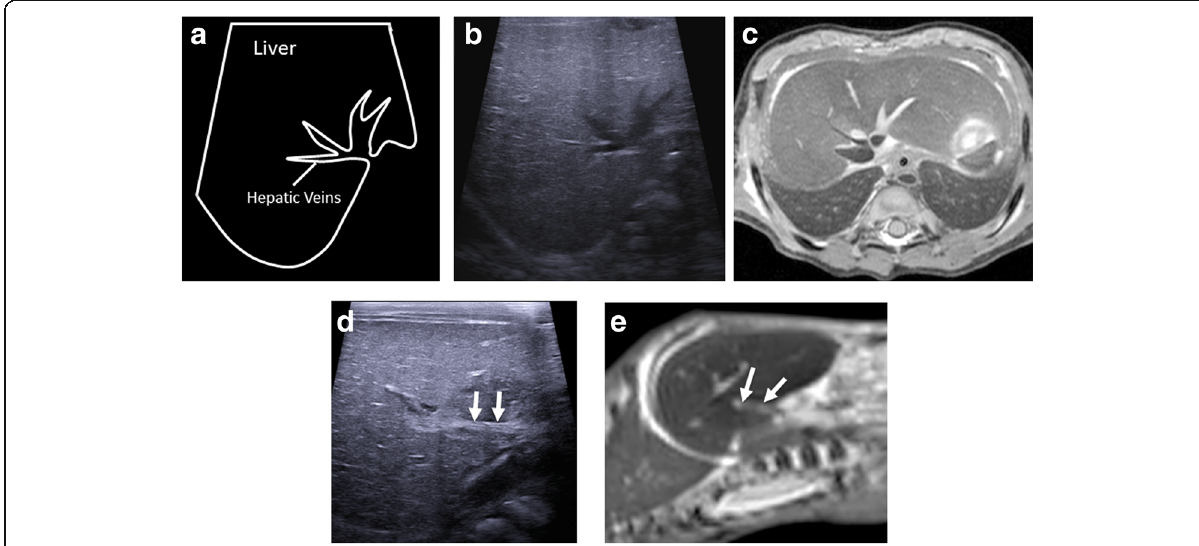
Fig. 12 Matching transverse upper abdominal views in labelled diagram format ( a ), postmortem ultrasound ( b ) and T2-weighted MRI at 1.5T imaging ( c ) of the same 36-week gestational-aged foetus 3days after death demonstrating haemostasis in the hepatic veins. The corresponding sagittal postmortem ultrasound ( d ) and matched T2-weighted MRI ( e ) views of the thrombosed main portal vein (white arrows) are also shown. This imaging example shows how even with decent sonographic windows in a well-preserved foetus, the common bile duct is quite difficult to delineate